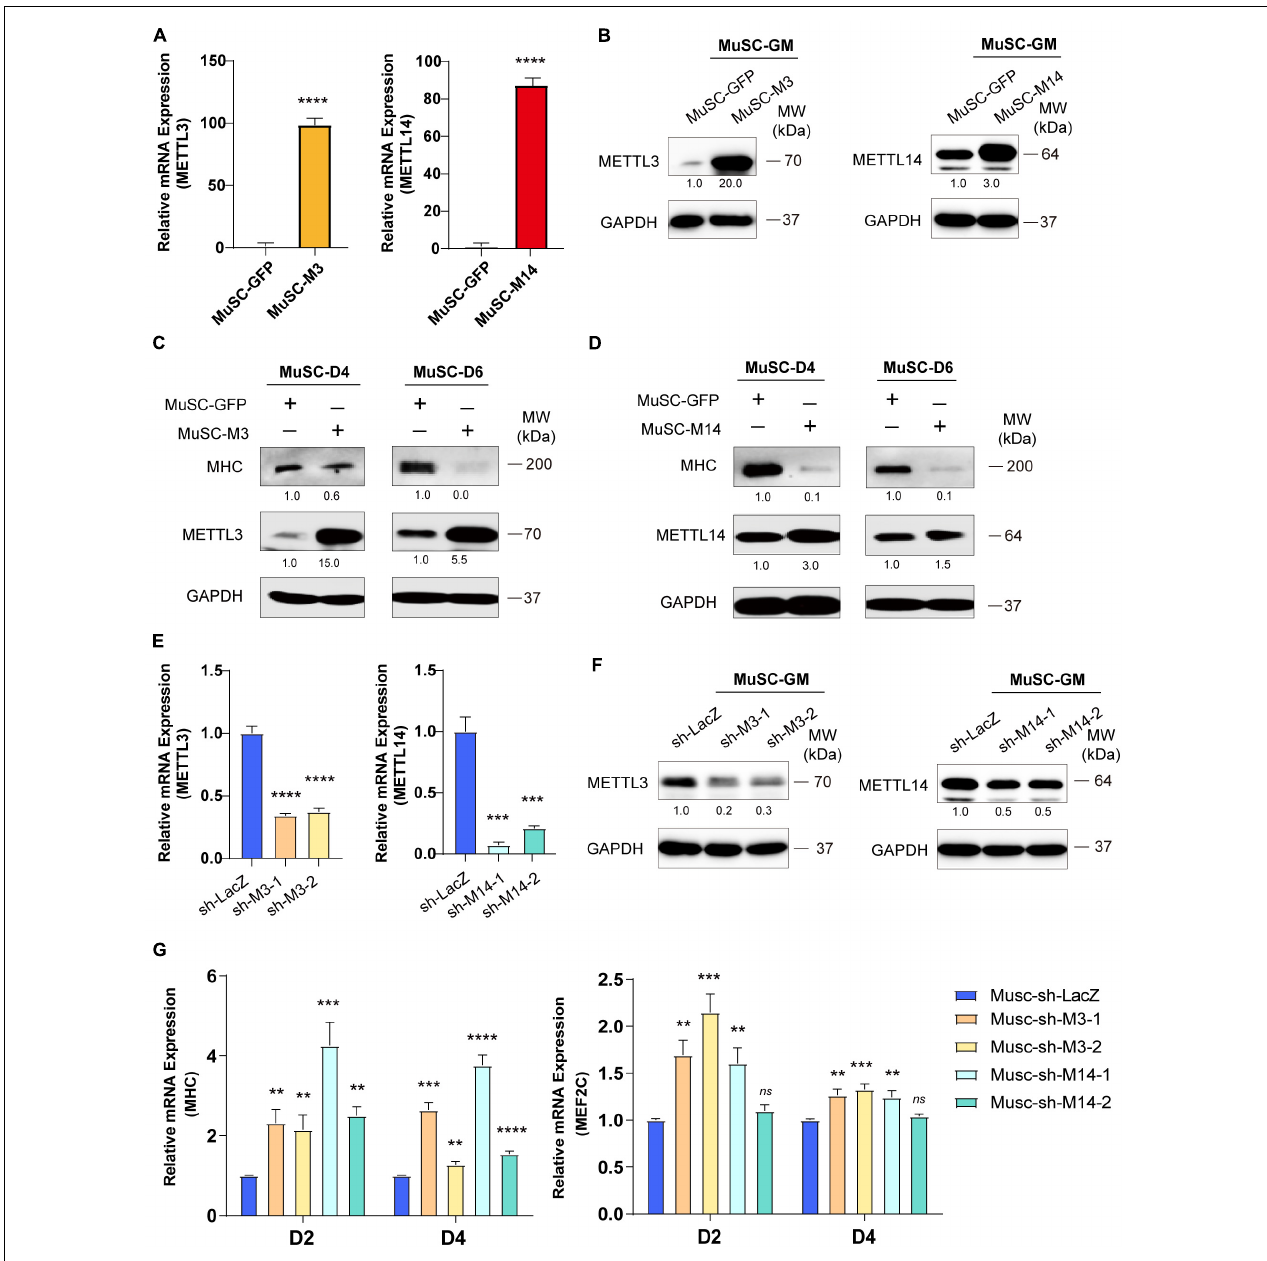
FIGURE 2 | METTL3/14 blocks the differentiation of primary mouse skeletal muscle cells. The expression of METTL3 and METTL14 in the indicated METTL3- or METTL14- overexpressing MuSCs were determined by (A) Real-time PCR and (B) western blot. The expression of myogenic marker MHC in METTL3- (C) or METTL14- (D) overexpressing MuSCs upon differentiation for 4 or 6 days were detected by western blot. (E) Real-time PCR analysis of the RNA expression levels of METTL3 or METTL14 in the indicated METTL3/14 knockdown MuSC stable cells. (F) METTL3 or METTL14 were determined by western blot in indicated METTL3/14 knockdown MuSC stable cells. (G) Real-time PCR analysis of the RNA expression levels of myogenic marker MHC and MEF2C were determined in D2 and D4. Quantitative data was represented as Mean ± SD. ** p < 0.01, *** p < 0.001, **** p < 0.0001, ns stands for not statistically